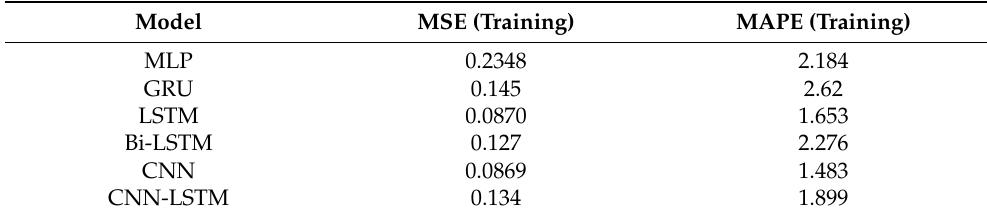
Table 6. The models’ training results using Snapchat data with four input